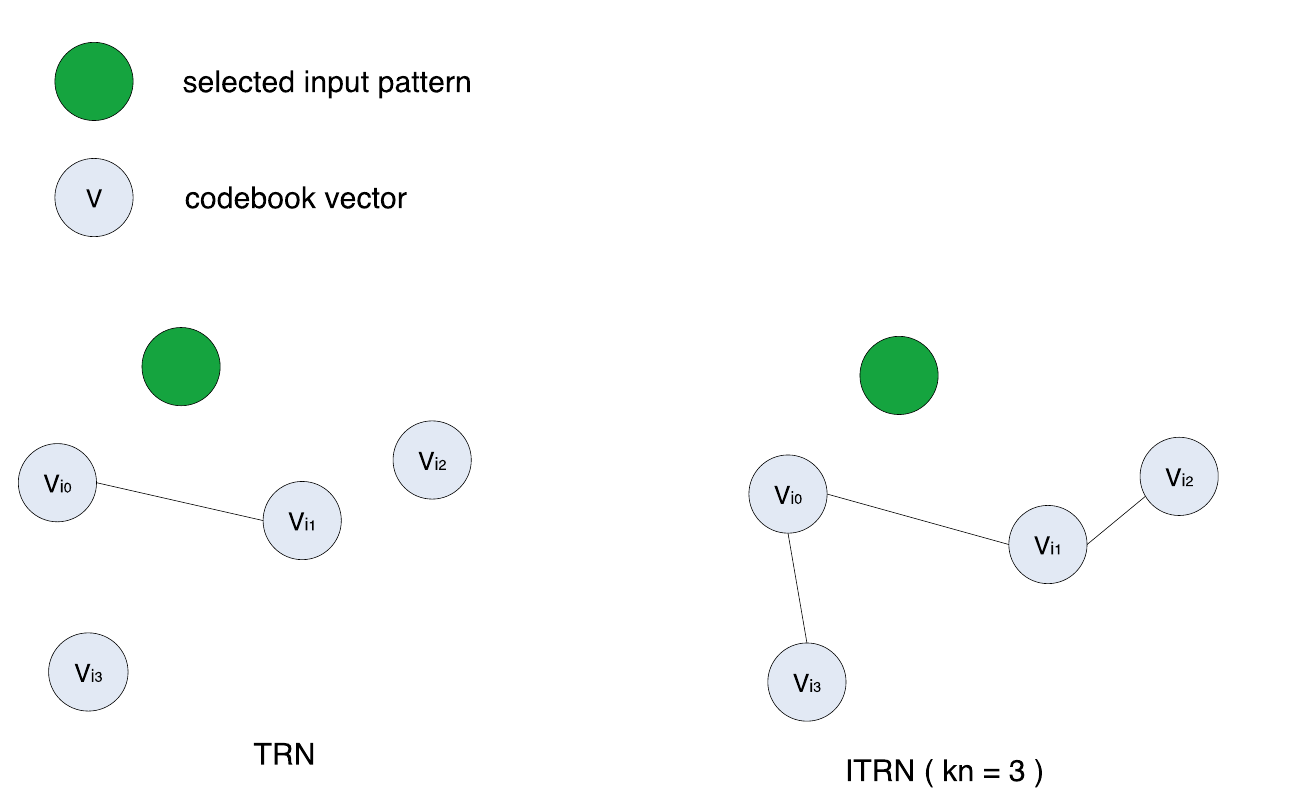
Fig 1. Different strategies to establish